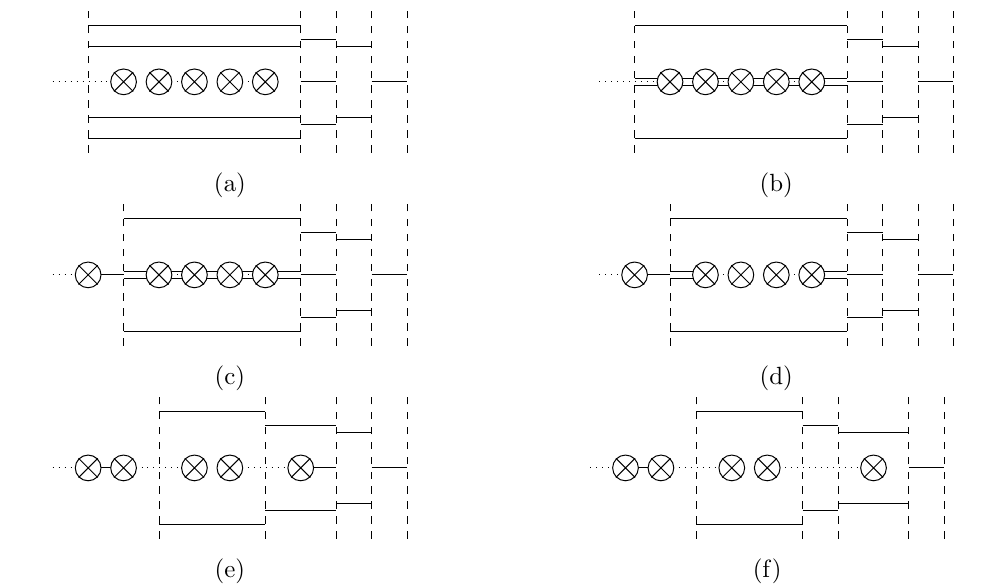
~l Figure 33. A d = (4 ; 4 ; 4 ; 4 ; 4), 3 Kraft-Procesi transition. The starting model has n s = n d = 5, ~l (cid:0) . (a) Higgs branch of the initial model. (b) We focus s = (0 ; 2 ; 0 ; 2 ; 0) and rightmost O3-plane O 3 on one of the leftmost physical D3-branes, considering all the rest as spectators. We align this brane with the half NS5-branes at the orientifold plane. Some vector multiplets in the e(cid:11)ective gauge theory become massless at this position. The D3-brane is split into six di(cid:11)erent segments, four